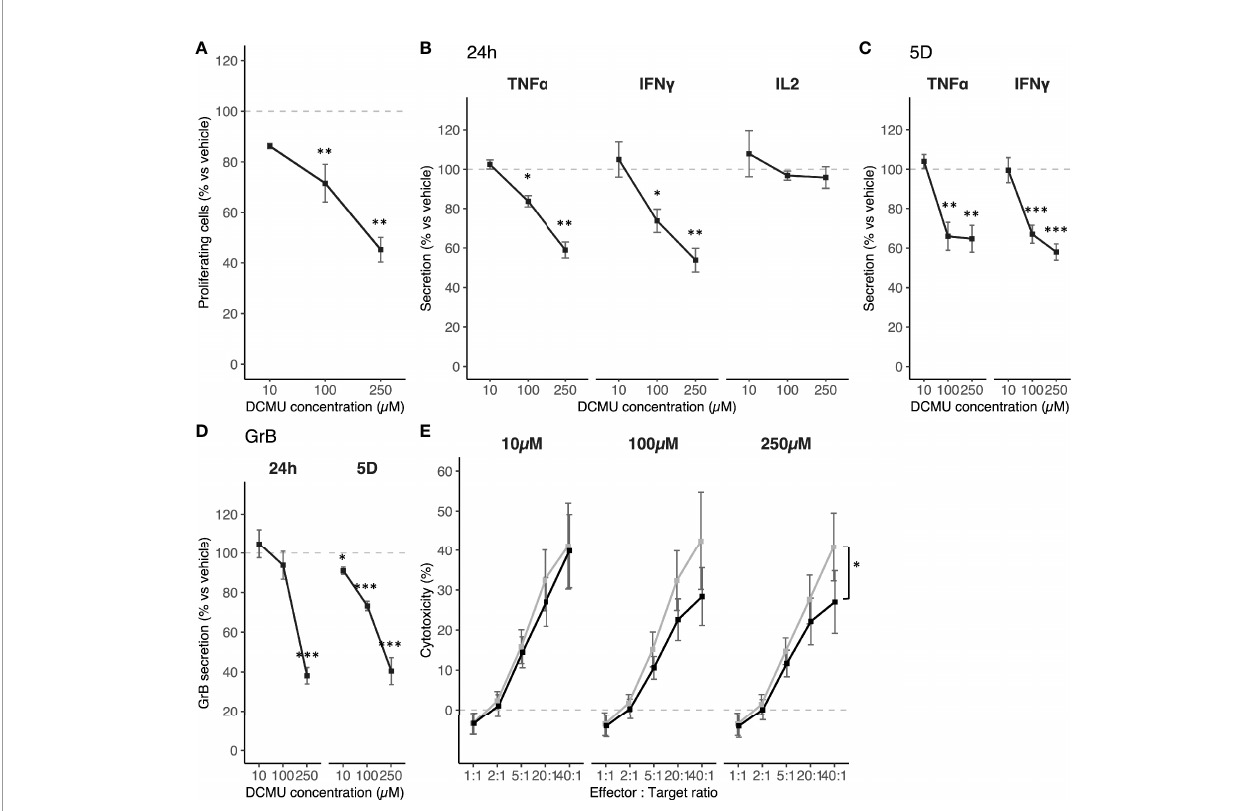
FIGURE 2 | DCMU exposures impact on human CTL03.1 cells in vitro. (A) CTL03.1 proliferation under DCMU exposures. (B) TNF- a , IFN-y and IL-2 protein concentrations in supernatant of CTL03.1 cells exposed to DCMU during 24h. (C) TNF- a and IFN-y protein concentrations in supernatant of CTL03.1 cells 4 days after the end of DCMU exposures. (D) Granzyme B protein concentrations in supernatant of CTL03.1 cells exposed to DCMU during 24h (24h) or 4 days after the end of exposure (5D). (E) Cytotoxicity assays against M113 cells by CTL03.1 cells. In black CTL03.1 cells exposed to DCMU, in grey CTL03.1 cells exposed to vechicle only. Each time 3 independent experiments were run in triplicate per condition. Statistical signi fi cance. * p ≤ .05, ** p ≤ 0.01, *** p ≤